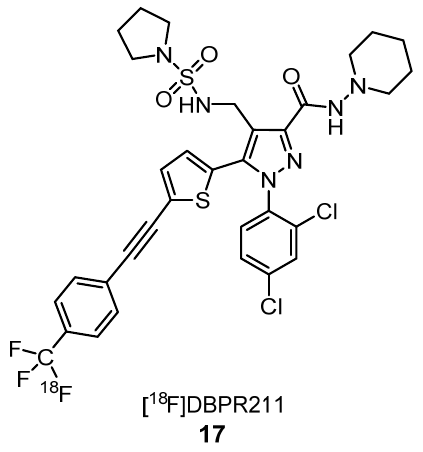
Figure 6. [ 18 F]pyrazole-derived peripheral CB 1 antagonist 17 [46].